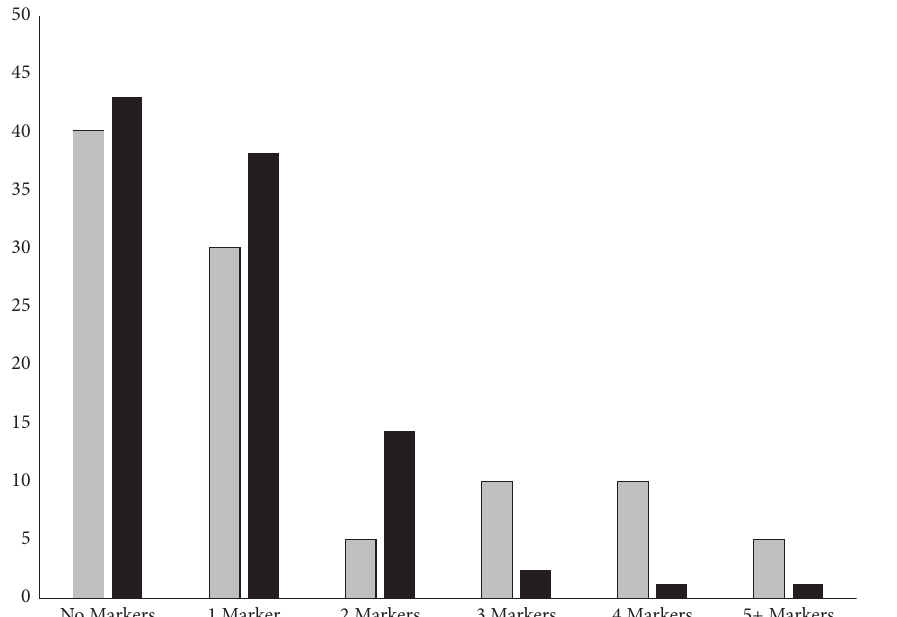
Figure 6: Frequency (in %) of ultrasound markers of TAPVR between cases (black) and controls (light grey). Table 2: Sensitivity and specifcity (with 95% confdence intervals) of the proposed diagnostic algorithms of TAPVR. Diagnostic